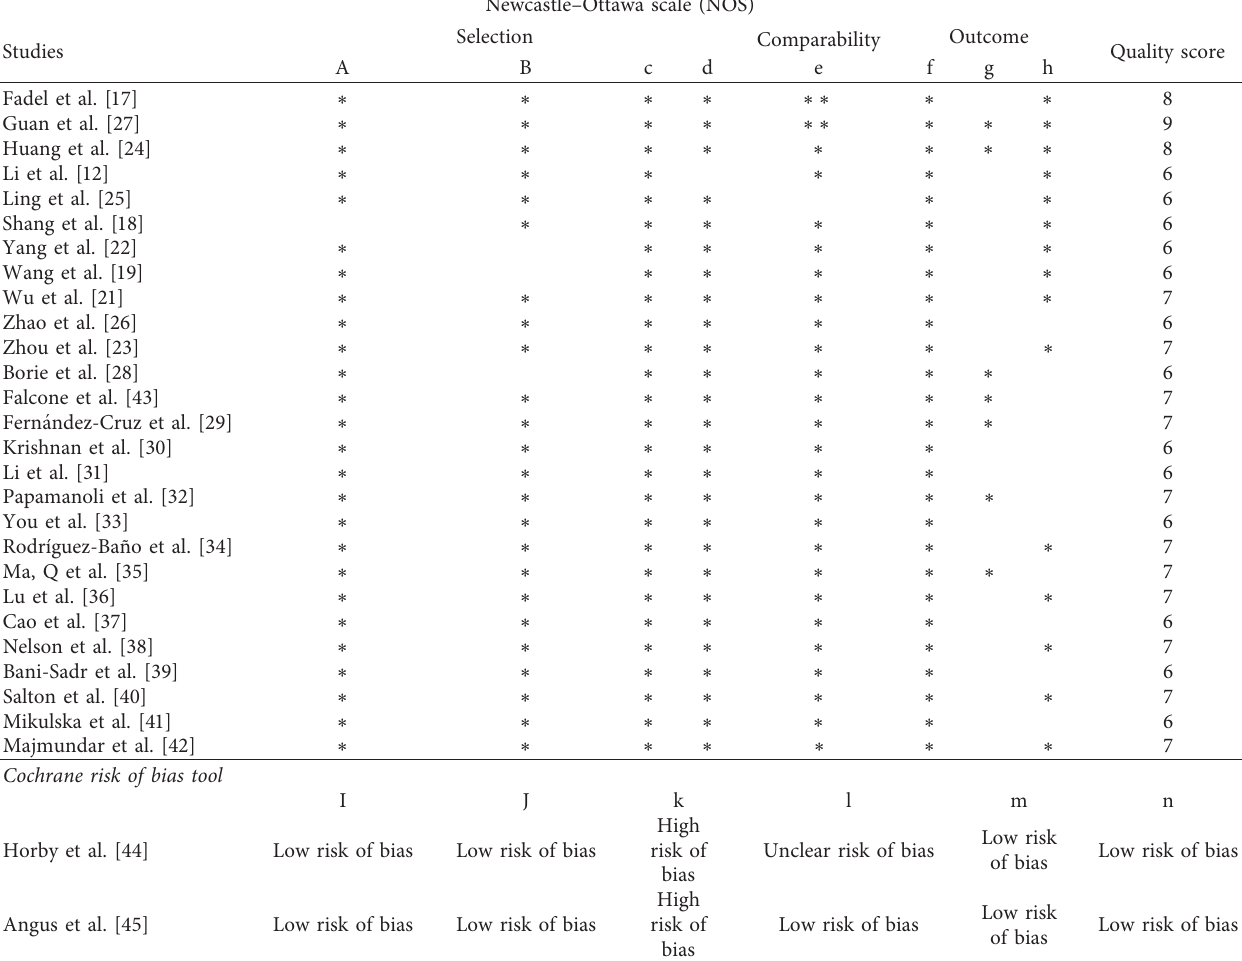
Table 3: Methodological quality